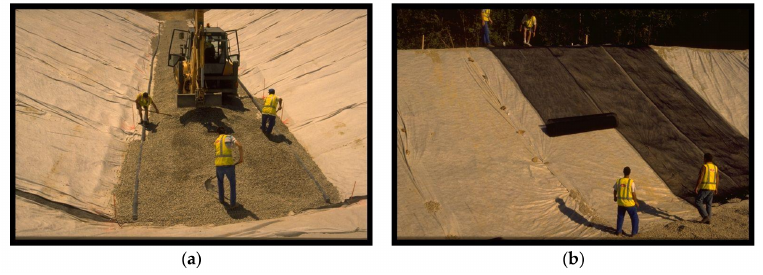
Figure 4. ( a ) Bottom and; ( b ) lateral watertight during the placement.